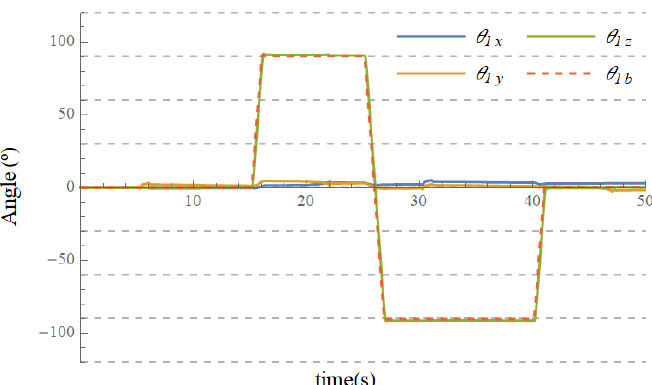
Figure 13. Evolution of Rotation Vector 1 when testing the link model using all measurements.